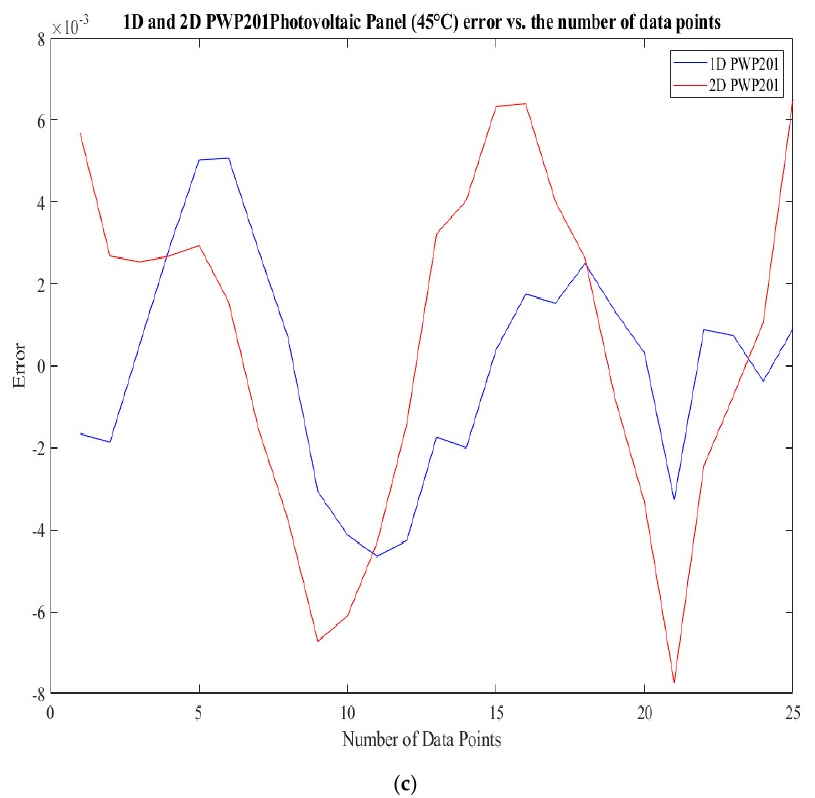
Figure 5 . PWP201 photovoltaic panel: ( a ) measured and calculated I-V characteristic for SDM; ( b ) measured and calculated I-V characteristic for DDM; ( c ) SDM and DDM errors comparison. The dataset for the Sharp ND-R250A5 photovoltaic panel [23] and the calculated cur- rent using SMD and DDM models and the errors are presented in Table 14. It consists of 60 polycrystalline silicon photovoltaic cells connected in series [23]. The current–voltage characteristic was measured at 59 °C under 1040 W/m 2 illumination. Table 14. (I, V) points of Sharp ND-R250A5 photovoltaic panel.